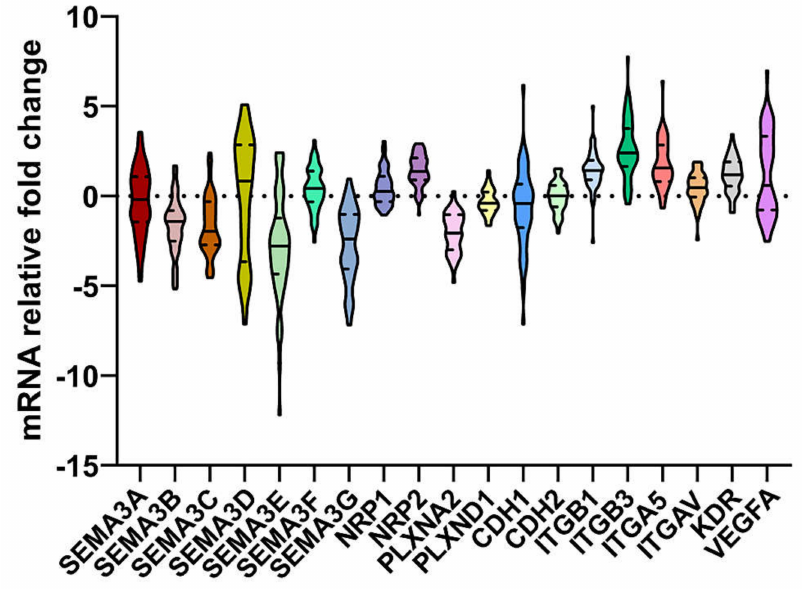
Figure 1. The distribution of mRNA levels of class 3 semaphorin (SEMA3) signaling genes in 59 astrocytoma samples. The solid line inside the violin represents the median, the dotted lines inside the violin represent quartiles. Relative fold change of mRNA is presented as 2 − ∆∆ Ct (The gene expression in normal brain tissue was normalized to 0